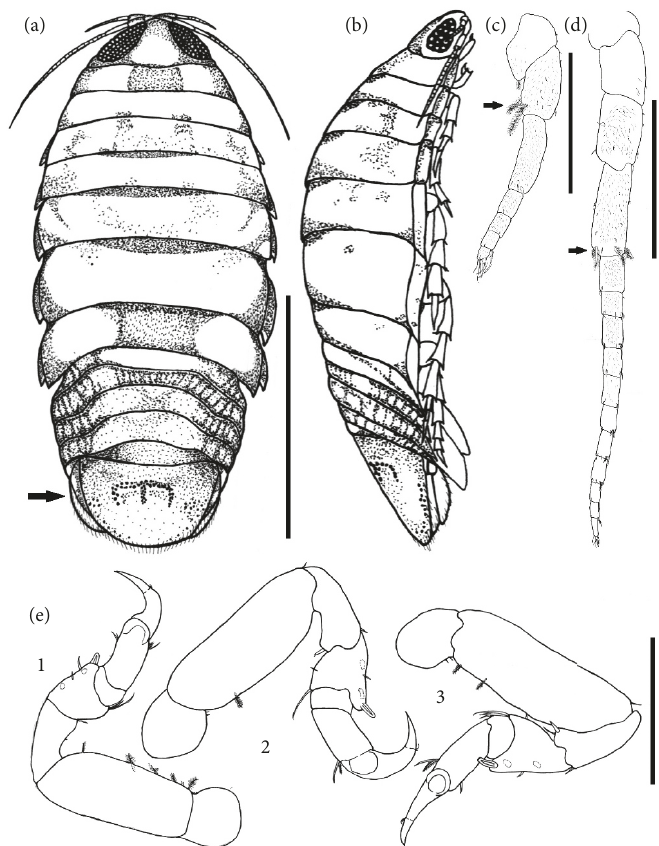
Figure 1: (a) Illustration of Rocinela signata collected from specimens of Lutjanus analis and Lutjanus jocu . Arrow shows the pleotelson with the typical mark of “inverted W”. Bar: 5 mm; (b) lateral view; (c) Detail of antenna I. Bar: 0.6 mm; (d) Detail of the antenna II. Bar: 0.7 mm. Arrows in (b) and (c) show the feathery bristles of the antennae. (e) Detail of the first three pairs of legs, bar: 0.4